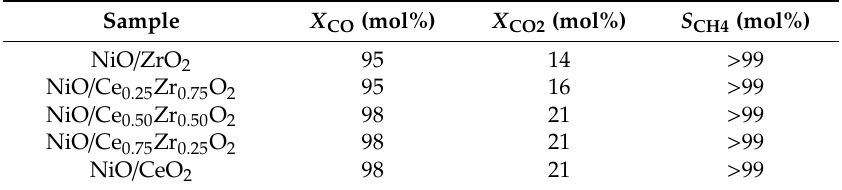
Table 2. 6-h average CO conversion ( X CO ), CO 2 conversion ( X CO2 ), and CH 4 selectivity ( S CH4 ) for the Ni/Ce x Zr 1- x O 2 samples in the CO x co-methanation reaction. T = 300 °C; CO/CO 2 /H 2 = 1/1/5; SV = 150,000 cm 3 h − 1 g cat − 1